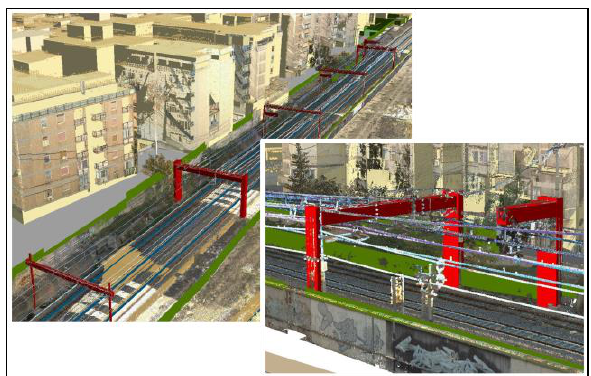
Figure 10 - 3D integration of different sources of railway